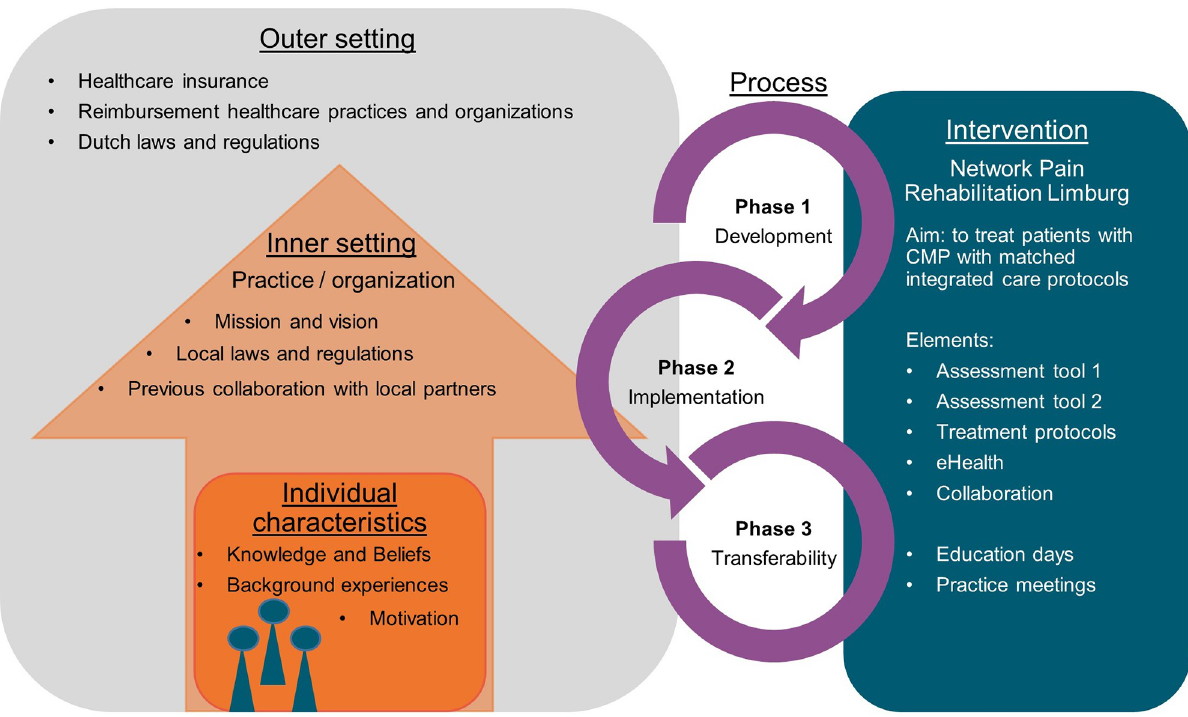
Fig 1. Consolidated framework for integrated care adjusted for Network Pain Rehabilitation Limburg.